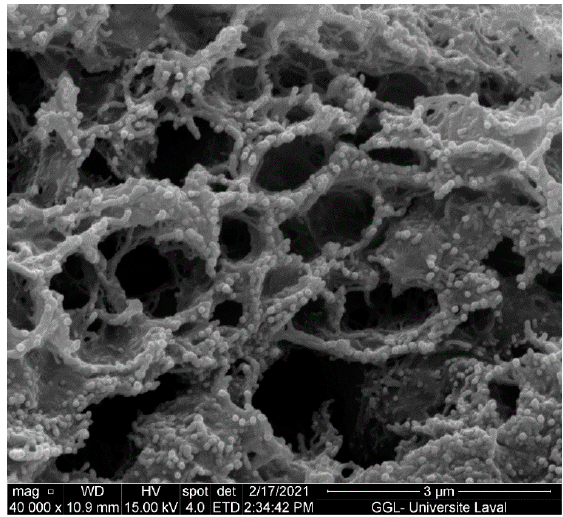
Figure 15. SEM micrograph of the resulting conductive network skeleton (after toluene extraction) from NCC/CNT/NR nanocomposites (reproduced with permission from [135]).